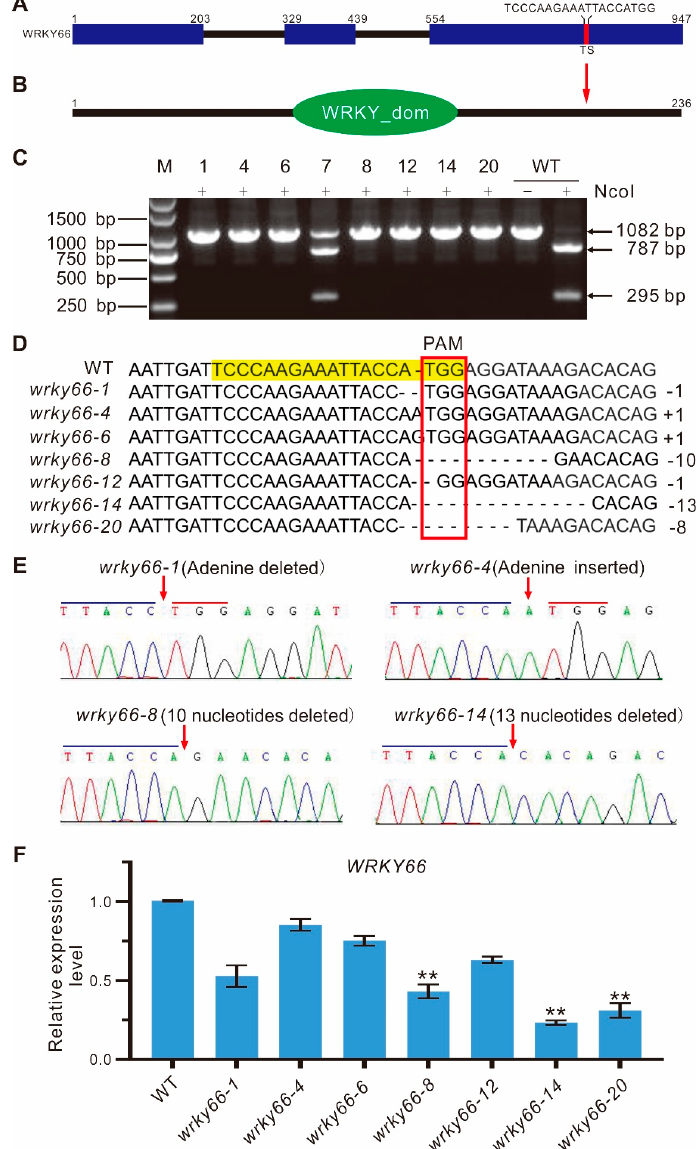
Figure 4. CRISPR/Cas9-mediated mutation details of the AtWRKY66 gene in the T2 generation of transgenic plants. ( A ) . Schematic illustration of the target site (TS) in the AtWRKY66 genomic sequence. The protospacer-adjacent motif (PAM) sequence was marked in red. The blue rectangle and black line indicated the exons and introns, respectively. ( B ). Location of TS in AtWRKY66 protein. The red arrow pointed to the TS site. ( C ). Identification of PCR products digested with restriction enzyme NcoI by gel electrophoresis. NcoI , PCR products digested with NcoI . The lengths of PCR products digested with NcoI were marked by arrow heads. The number on the lanes represents the different transgenic plant lines. The negative sign represented the no enzyme digestion, while the plus sign represented the enzyme digestion. M, DNA marker. ( D ). Comparisons and analyses of the PCR sequencing results of different transgenic plants. The gRNA sequence was labeled with light yellow and the PAM sequence was marked with a red box. ( E ). Detailed mutation information of the AtWRKY66 transgenic line (T2). DNA fragments around the target sequences were amplified by PCR and then subjected to a sequencing analysis. The PAM and the sgRNA target sequences were indicated by blue and red lines, respectively. Red arrows indicated the insertion of an alanine (A) nucleotide or the position of deleted nucleotides. ( F ). Relative expression levels of AtWRKY66 in mutants by qRT-PCR. The asterisk indicates that the fold changes of expression levels is greater < 0.5 than the WT plants (** p <